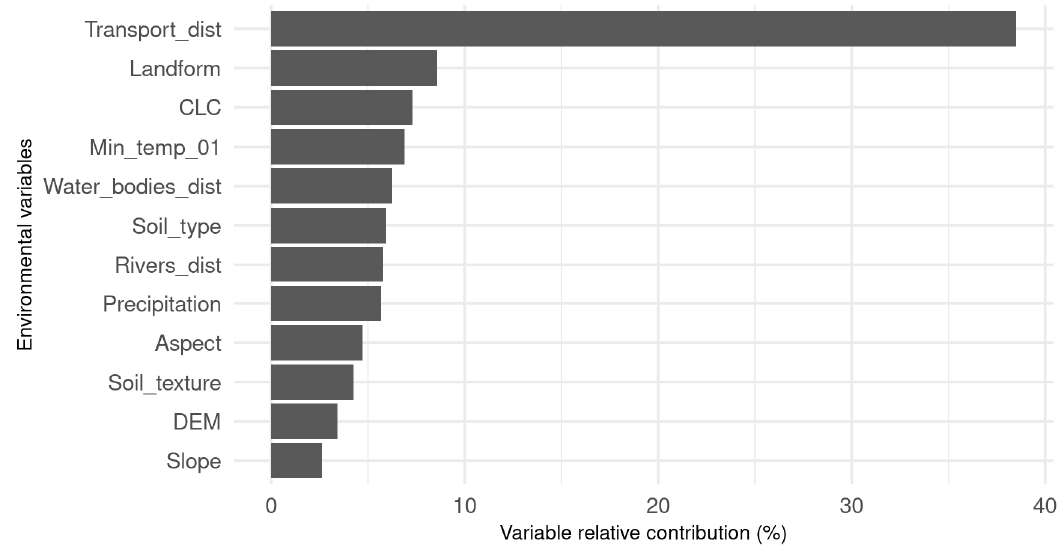
Figure 2. Ensemble model environment variable importance evaluated with Pearson.